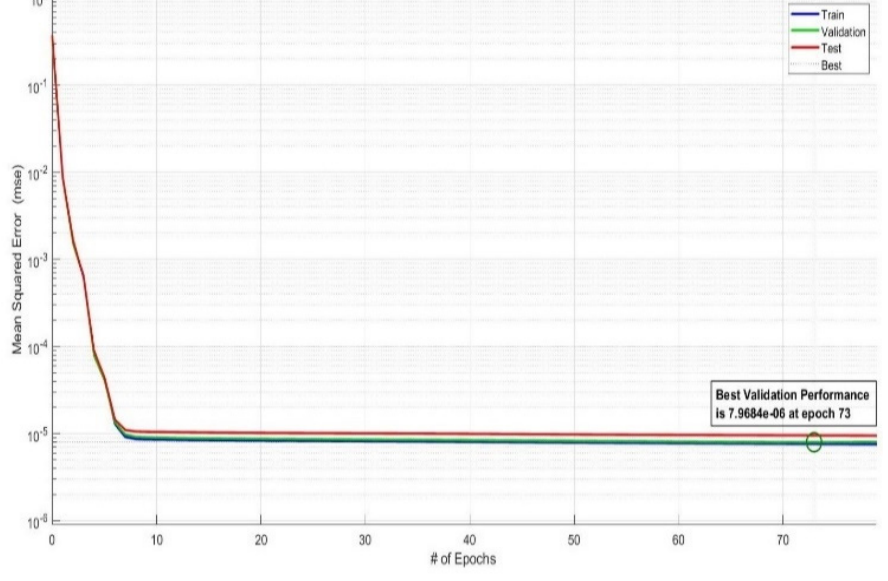
Figure 10. Training performance of NARX.